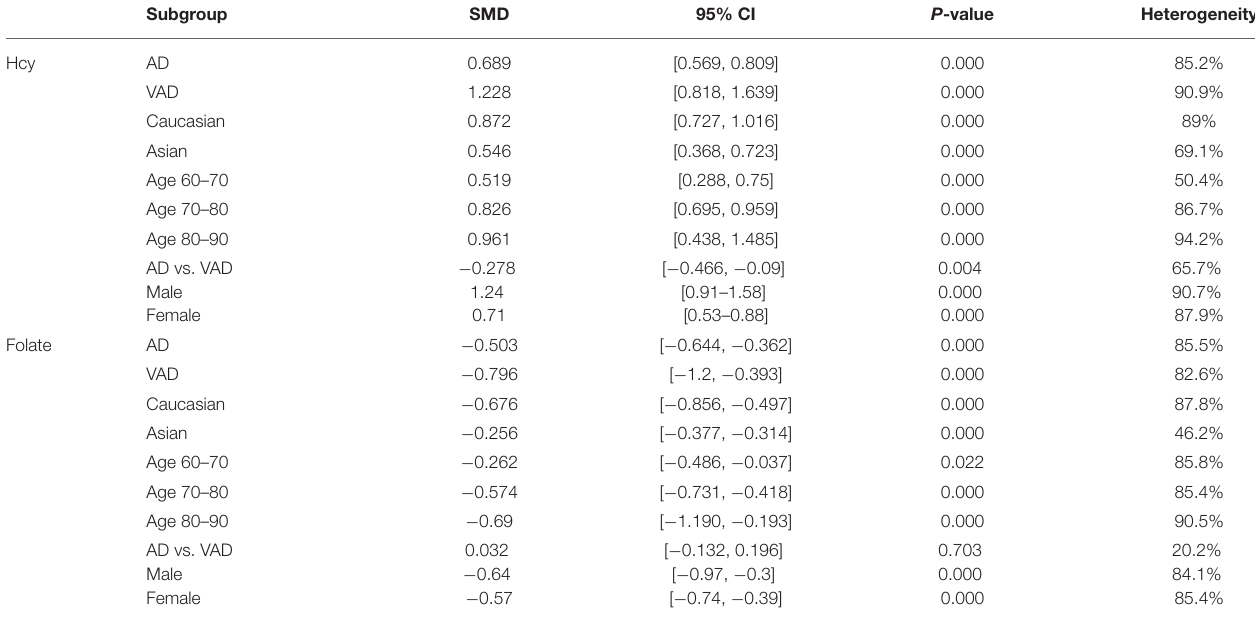
TABLE 3 | Summary of statistic results in our meta-analysis and subgroup analysis.